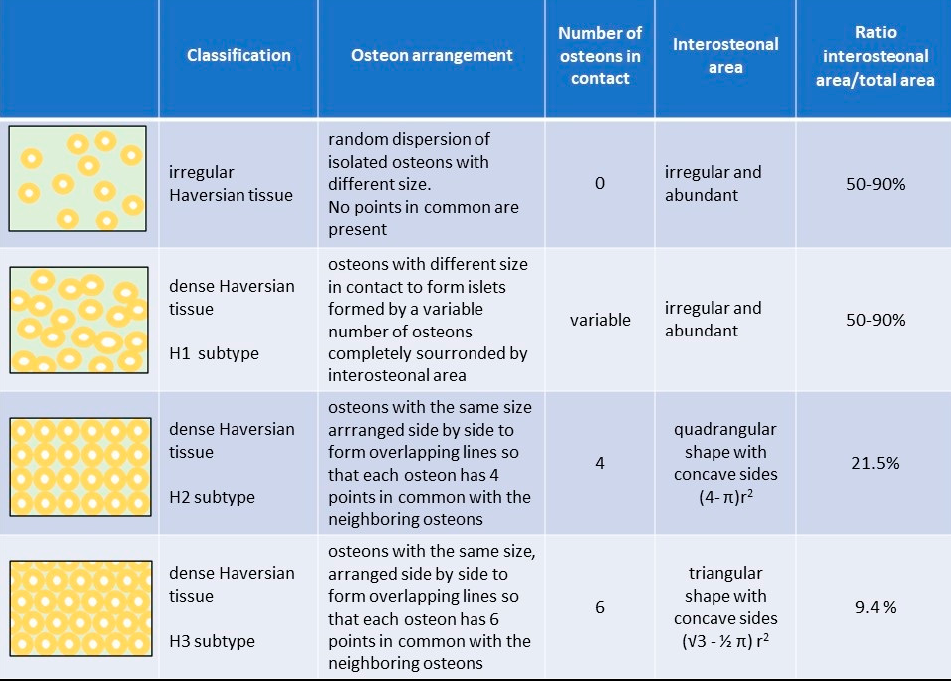
Figure 4. Schematic di ff erences among the subtypes of the Haversian tissue proposed.